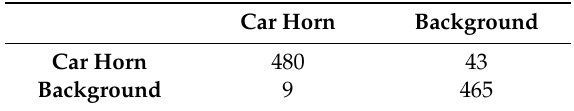
Table 8. Confusion matrix of the CNN model after